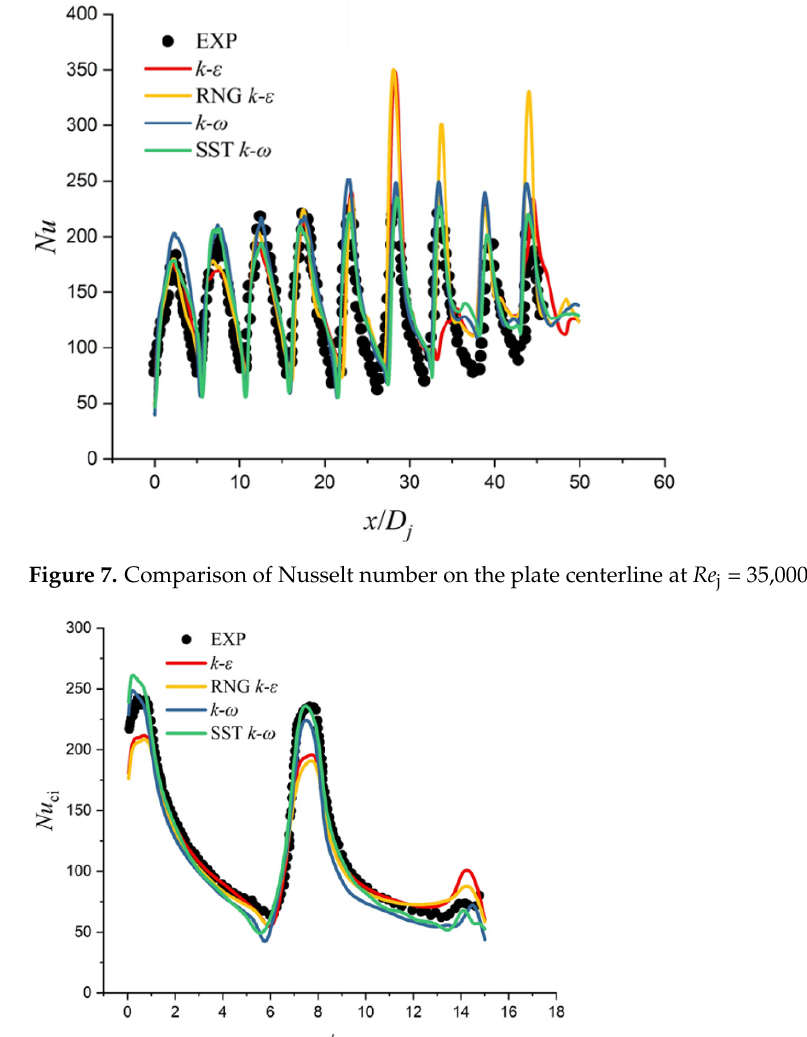
Figure 8. Comparison of circumferentially averaged Nusselt number results at Re = 10,000 and temperature ratio = 0.83.